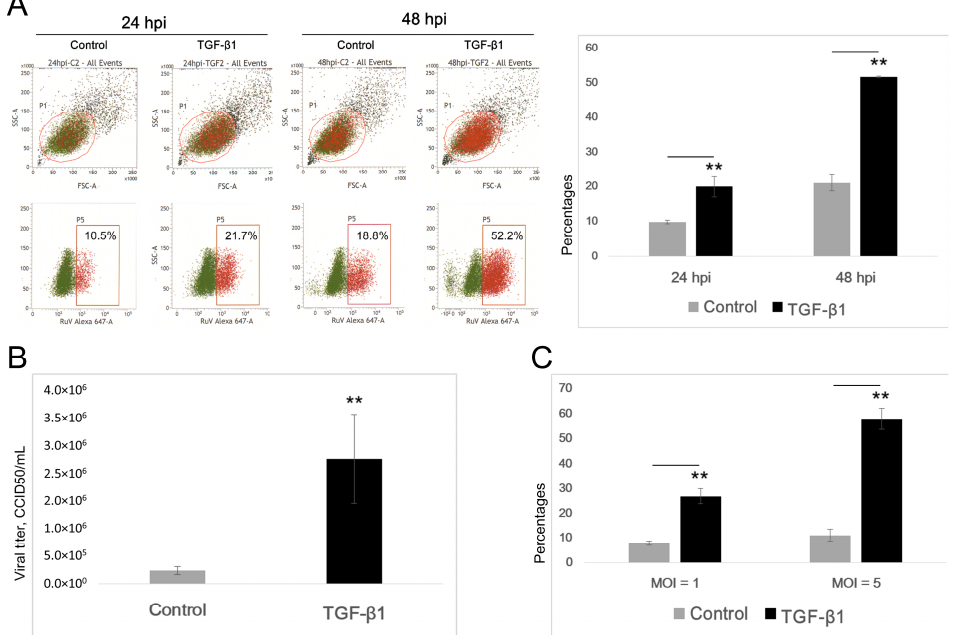
Figure 2. The TGF- β 1-induced EMT-like process enhances the RuV infection rate in A549 cells. ( A ) Percentages of A549 cells positive for RuV determined by FCM analysis at 24 and 48 hpi. A549 cells were seeded onto 96-well plates at a density of 10 4 cells/well and stimulated with TGF- β 1 (0, 10 ng/mL) for 24 to 48 h prior to virus infection (multiplicity of infection (MOI) = 1). The cells were collected at 24 and 48 hpi and labeled with a Live/Dead Fixable Near-IR Dead Cell Stain Kit. Intracellular staining was performed with a mouse monoclonal anti-rubella virus capsid antibody followed by a goat anti-mouse IgG H&L (Alexa Fluor 647) secondary antibody. ( B ) Titers of viral progeny in the supernatants collected at 48 hpi. ( C ) Percentages of A549 cells positive for RuV after the first round of infection, at an MOI of 1 and 5, determined by FCM analysis. After the TGF- β treatment, the cells were infected with RuV at an MOI of 1 or 5, and NH4Cl (20 mM) was added at 6 hpi to prevent a second round of infection. All the above results are expressed as the mean of at least three replicates in each group, and each graph is representative of three independent